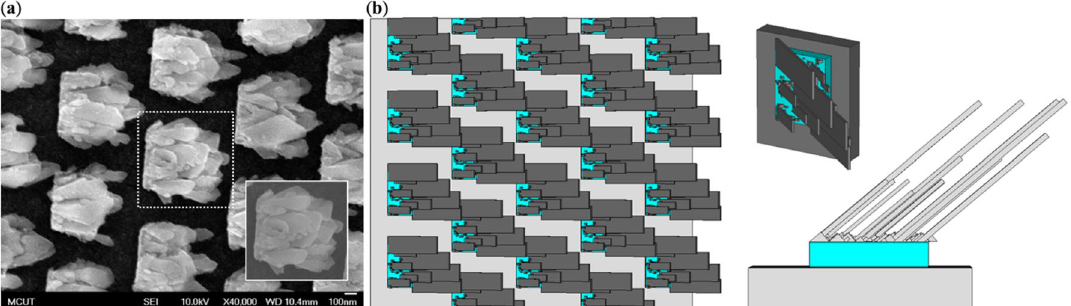
Figure 4. ( a ) SEM image of the fabricated multiple-oblique-flat-sheet (MOFS) MPA. ( b ) Constructed MOFS MPA in the aids of Visual Basic Application.